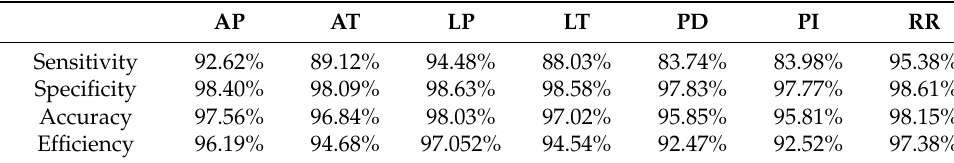
Table 7. Classifier performance parameters for the training stage.